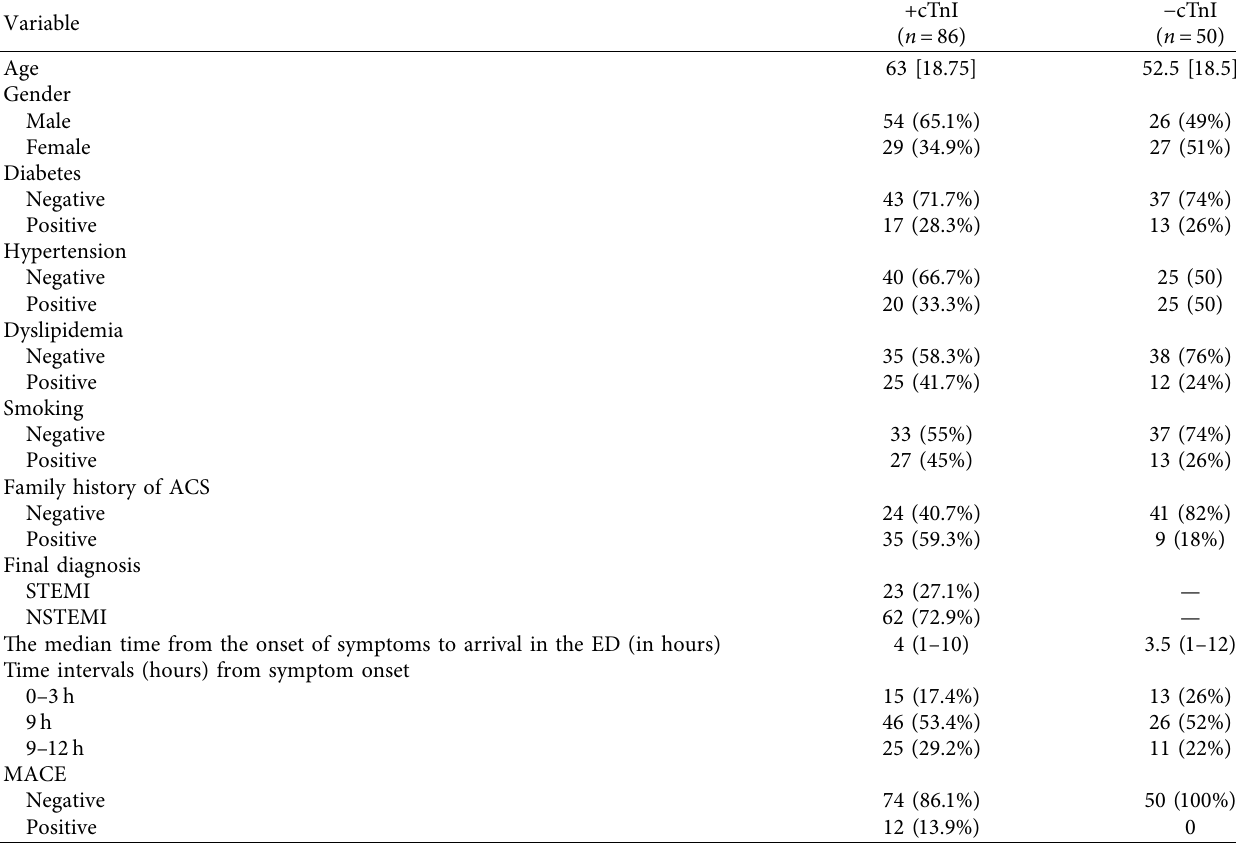
Table 1: Comparison of troponin positive and troponin negative